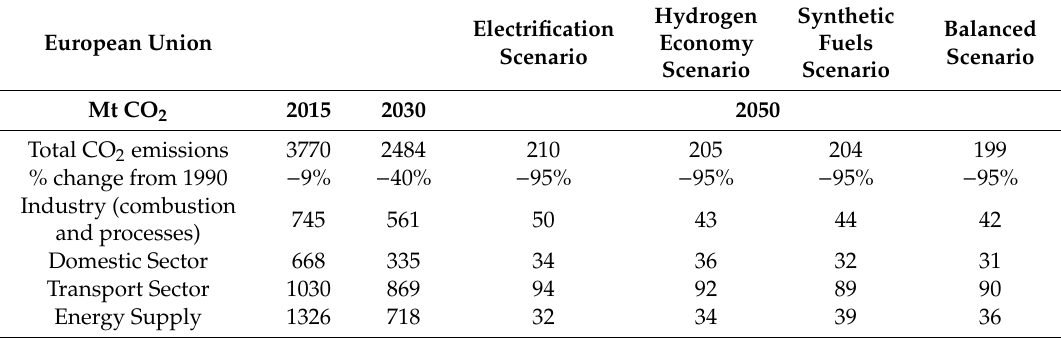
Table 3. CO 2 Emissions by sector in Mt CO 2